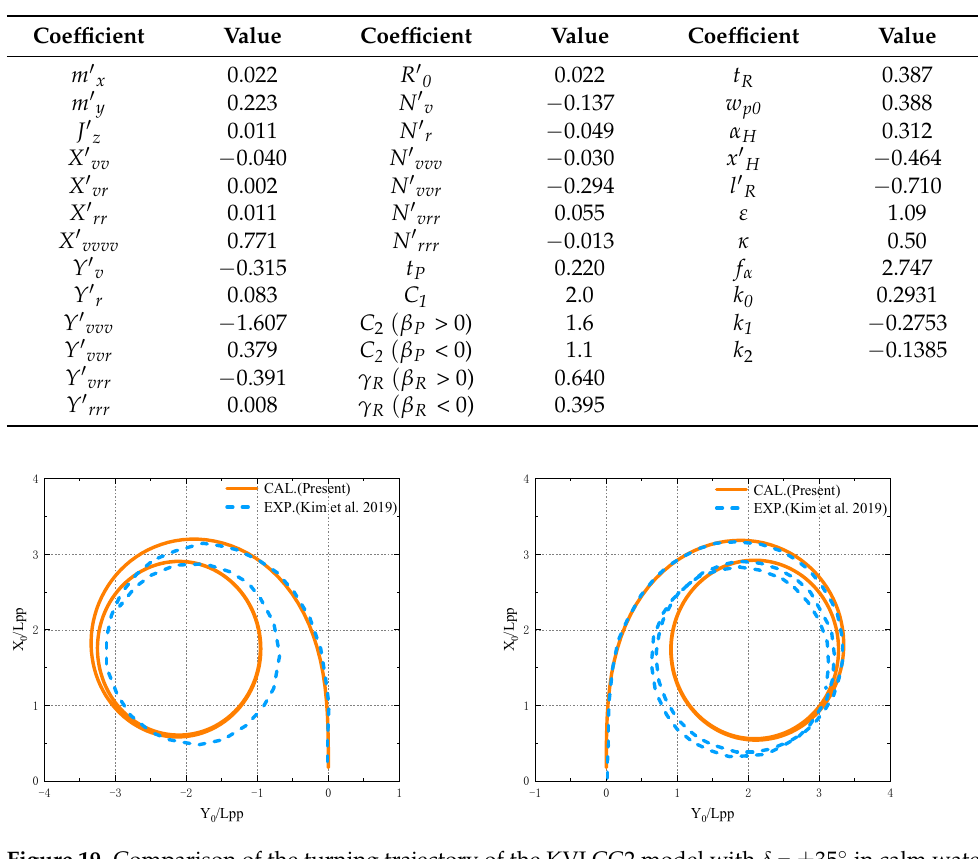
Table 2. Related coefficients used in the simulation.